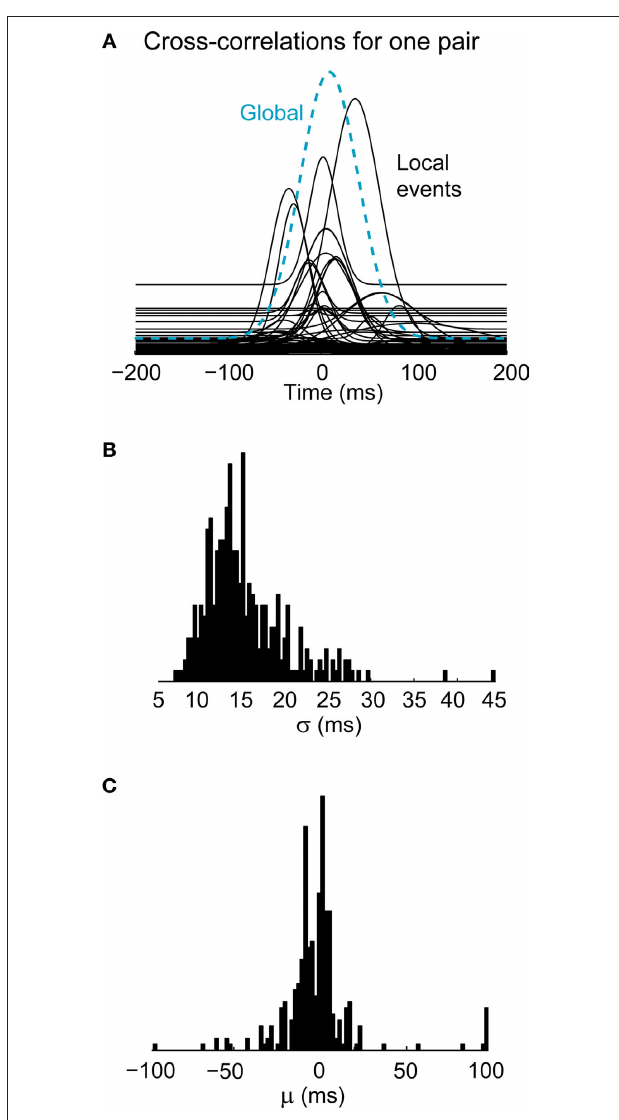
Figure 10 | Local variations in the temporal precision across LgN neurons. (A) Local (black) and global (dashed blue) cross-correlation functions for the pair of cells shown in Figure 8 . (B) Distribution of values of local cross-correlation width ( σ ) in all 38 cell pairs, for all shared events in which the peak of the cross-correlation function ( α ) was higher than 0.005 ( n = 321 events, median = 14.3 ms, mean = 15.4 ms, standard deviation = 4.8 ms). (C) Distribution of values of mean latency (μ) in all 38 cell pairs, for all shared events in which the peak of the local cross-correlation function ( α ) was higher than 0.005 ( n = 321 events, median = − 1.2 ms, mean = − 1.9 ms, standard deviation = 22.7